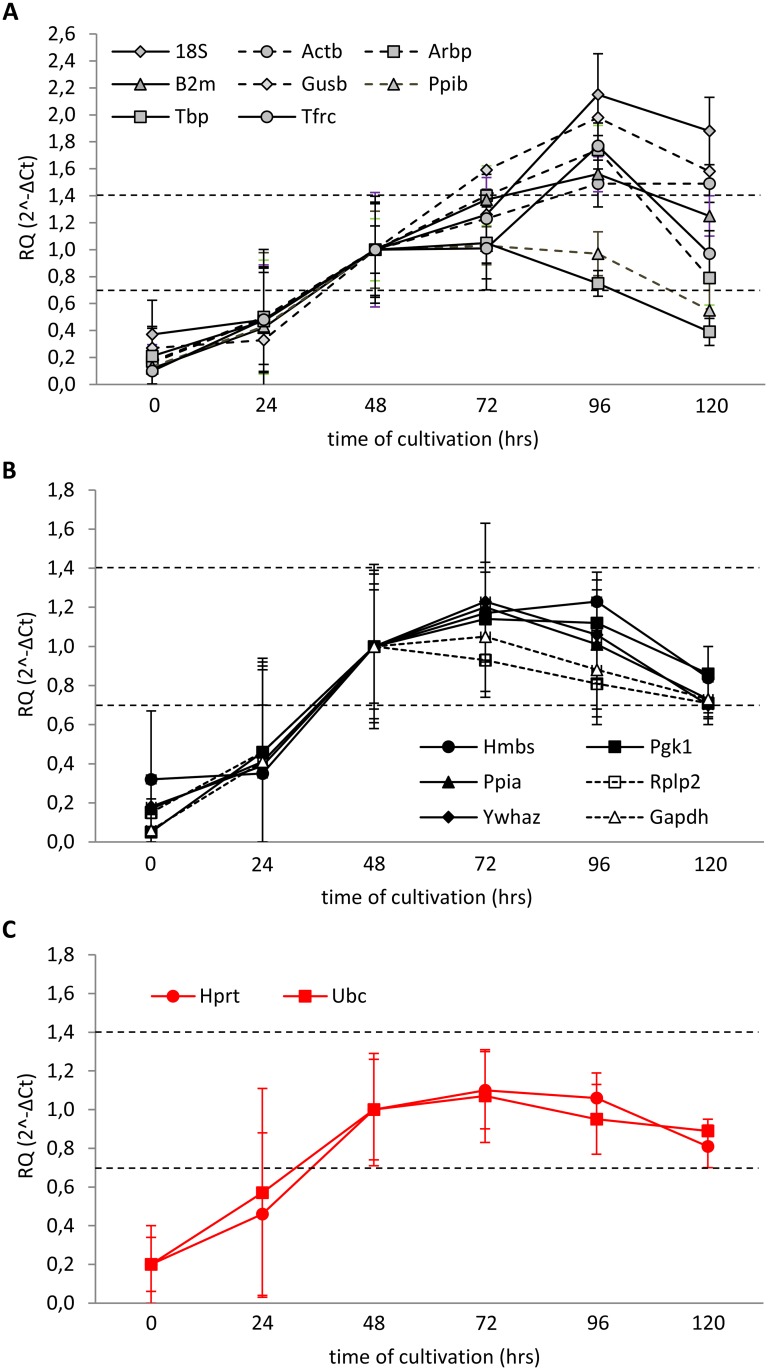
Expression stability of candidate RGs at different phases of cultivation evaluated according to the ±0.5 ΔCt rule.Data are expressed as means ± SD, n = 6. Dashed lines indicate the interval of 0.7-1.4-fold change compared with the expression at 48 hrs.